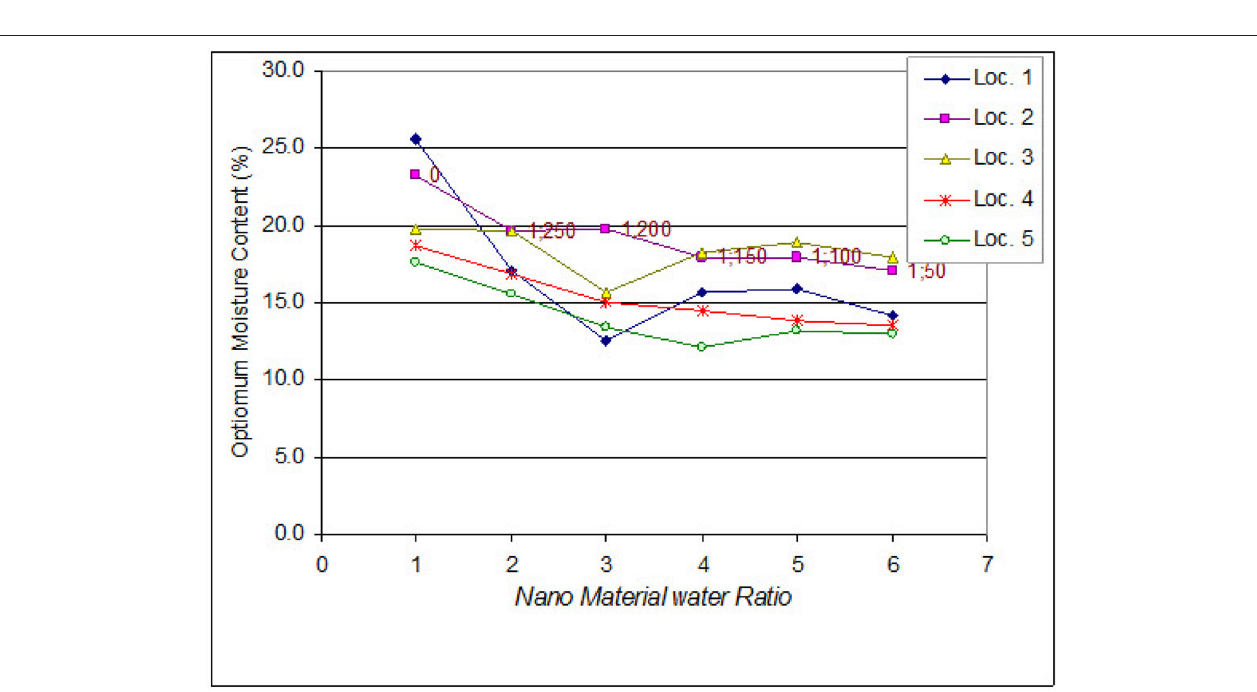
FIGURE 9 | Variation of optimum moisture content with nanomaterial (source: analysis of laboratory results).